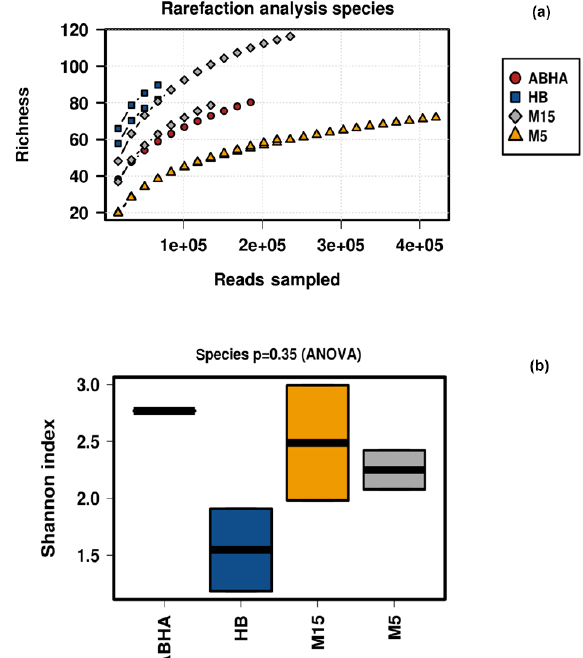
Figure 2. Estimates of alpha diversity. Samples are rarified to read depth of 68640. Panel (a) shows the rarefaction curves obtained determining the species richness, while (b) shows the Shannon di- versity indices for the desert soil samples studied.